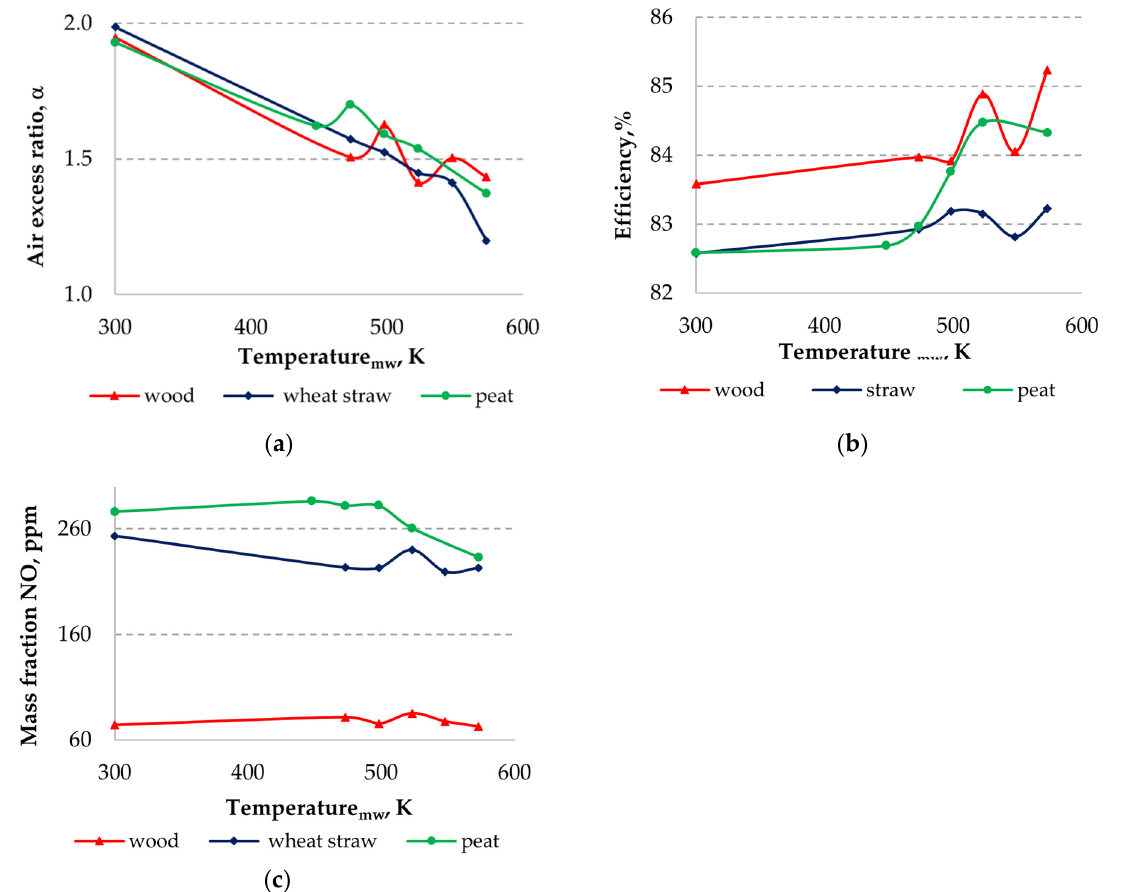
Figure 11. The effect of mw pretreatment on the average values of air excess ratio ( a ), combustion efficiency ( b ) and mass fraction of NO x emissions ( c ).